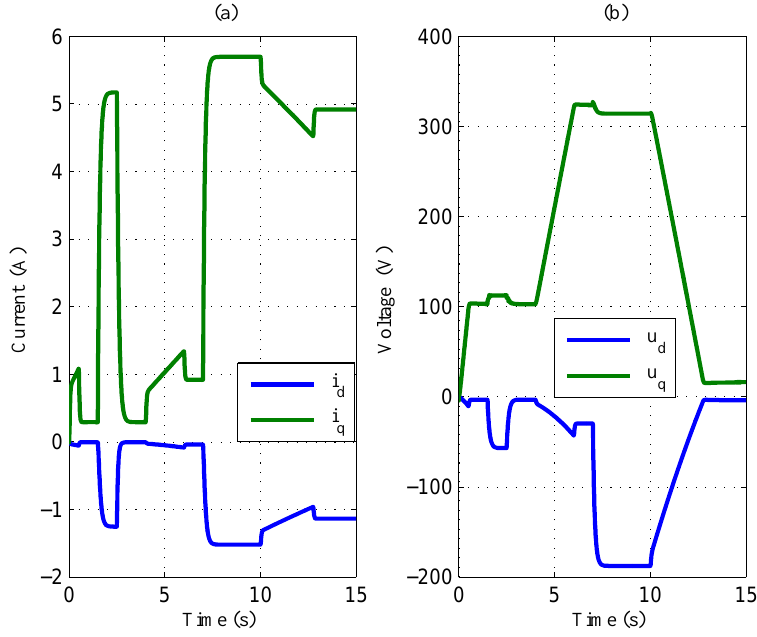
Figure 6. Tracking performance (nominal case): ( a ) dq currents; and ( b ) dq